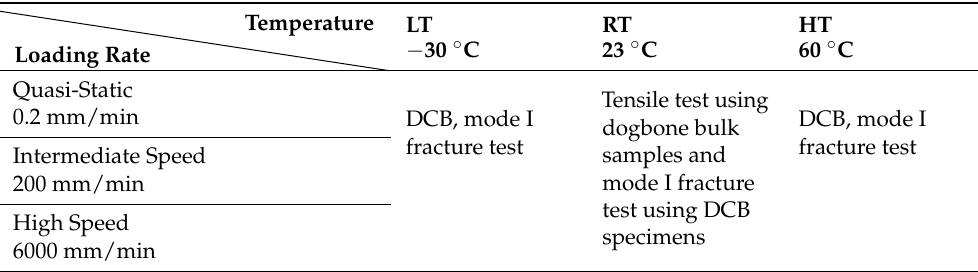
Table 2. Summary of the test